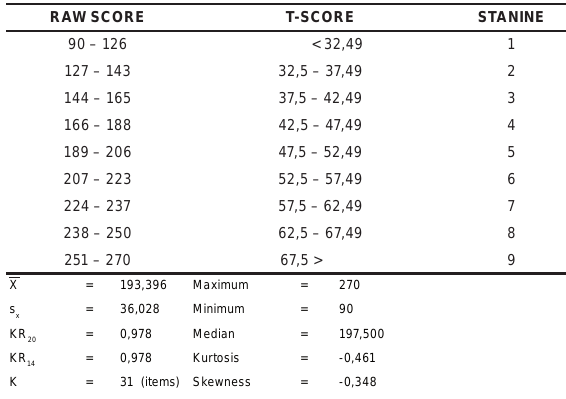
TAbLE 20 Transformation of raw scores to standard scores (shortened scale)